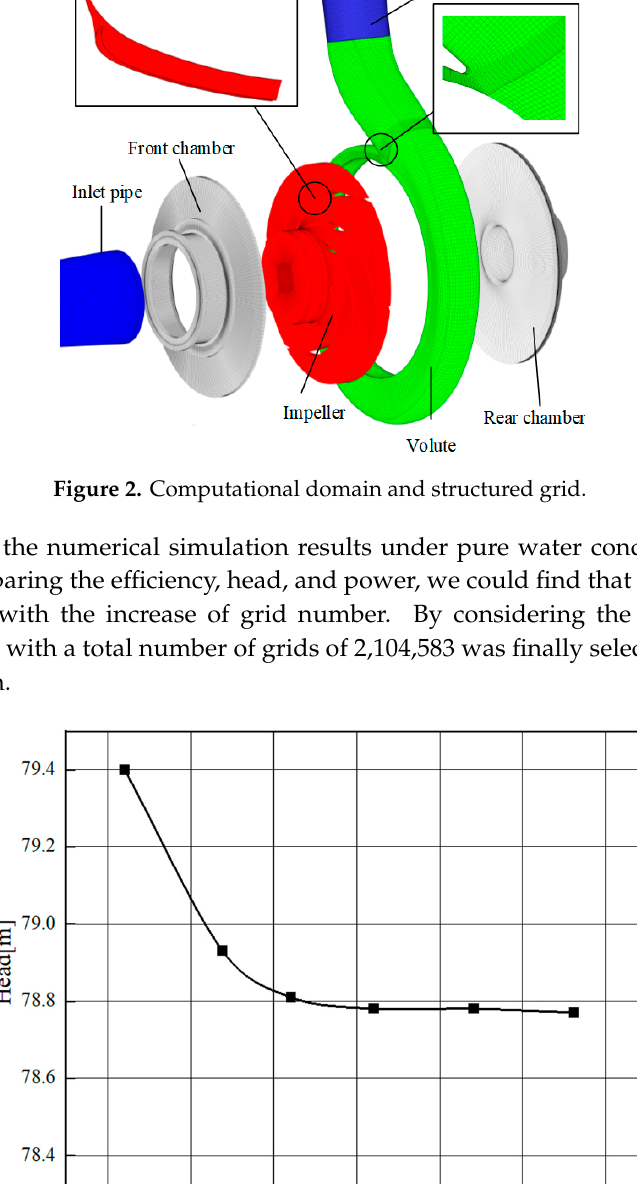
Figure 3. Grid independence analysis.